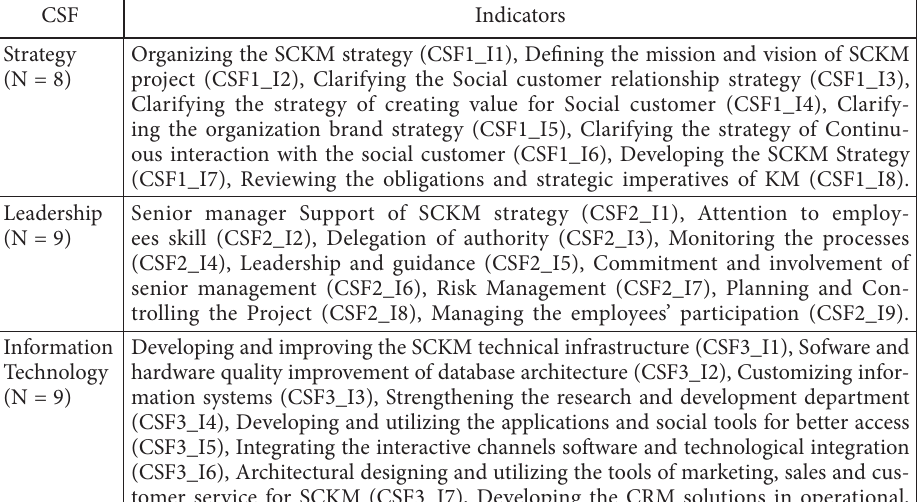
Table 3. CSFs and indicators of SCKM model (Lak, Rezaeenour 2017) CSF Indicators Strategy (N =